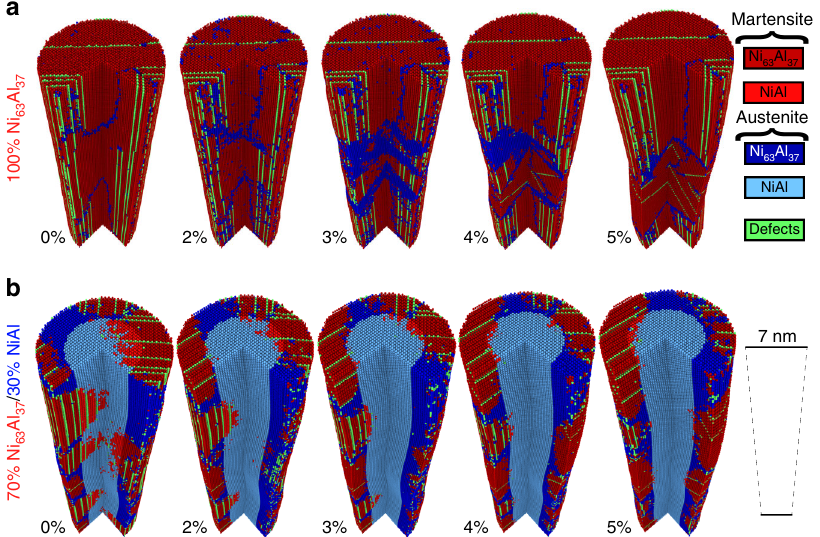
Fig. 3 Atomic structures contrasting homogeneous and metamaterial nanowires. a The homogeneous Ni 63 Al 37 nanowire accommodates uniaxial strain through nucleation of a new domain orientation. b 70 at% T-Shell metamaterial nanowire changes the local lattice parameter, fraction of martensite and austenite in each region, and relative fraction of multiple martensitic domains in response to strain. Atoms colored by phase through CNA; surface atoms were removed for clarity, as were a front quarter-section of